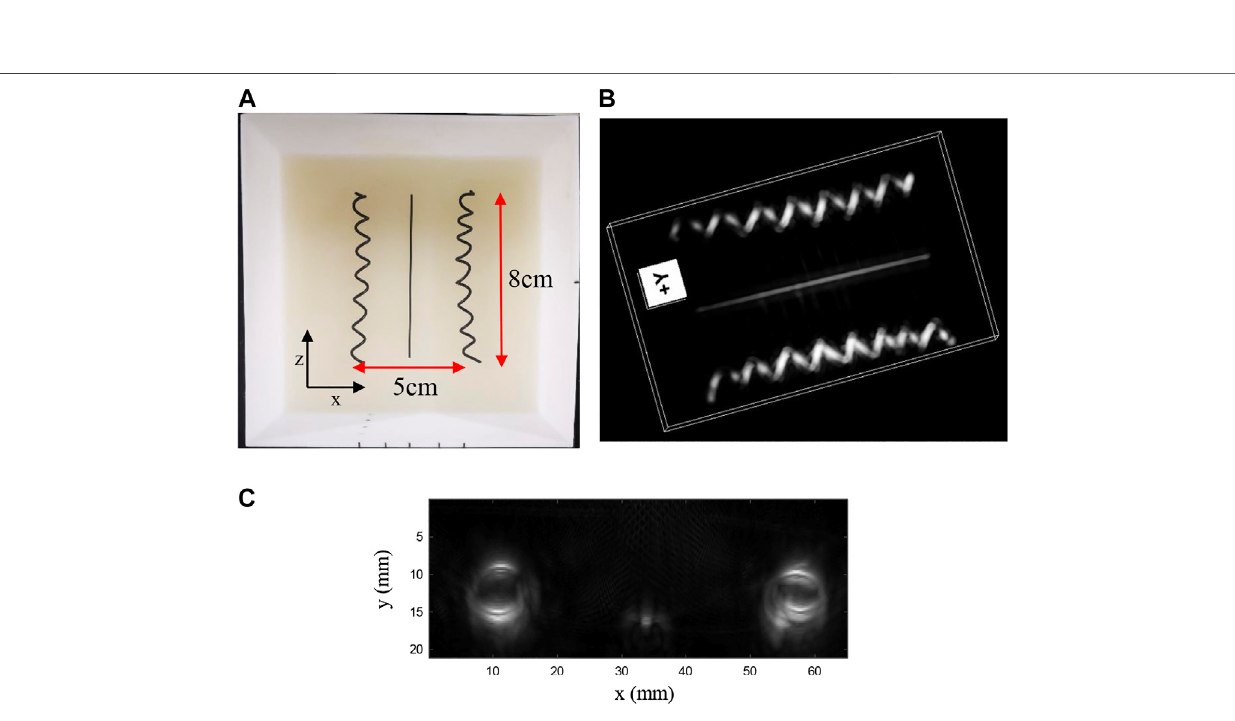
FIGURE 6 | (A) Photograph of carbon rods and helixes in scattering medium in phantom study; (B) 3D result of carbon rods and helixes; (C) MAP imaging of one period of the